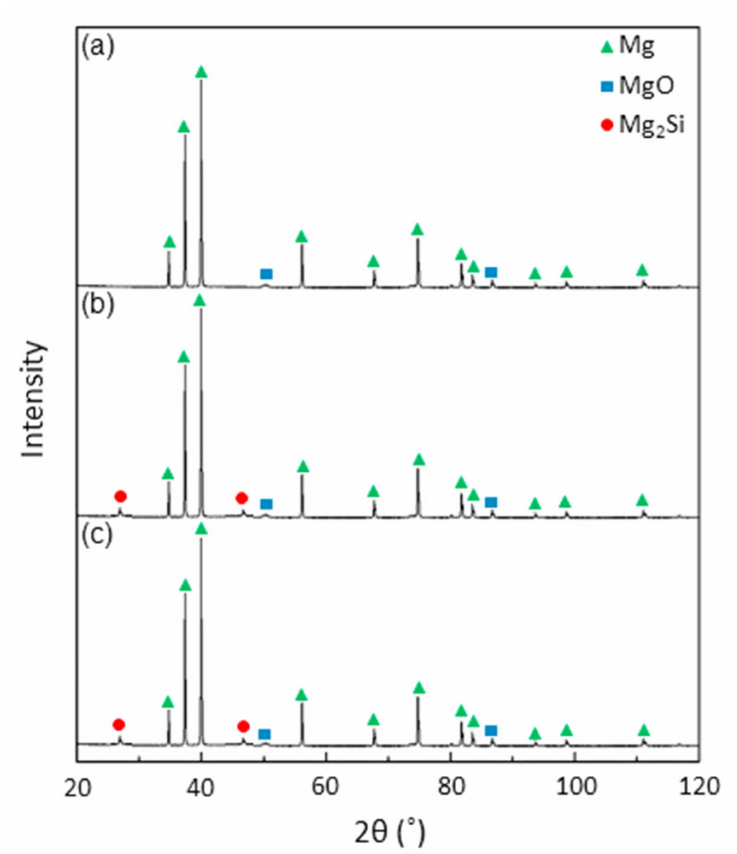
Figure 2. XRD pattern of sintered ( a ) Mg alloy AZ31, ( b ) Mg + 3% SiO 2 , ( c ) Mg + 5% SiO 2 .